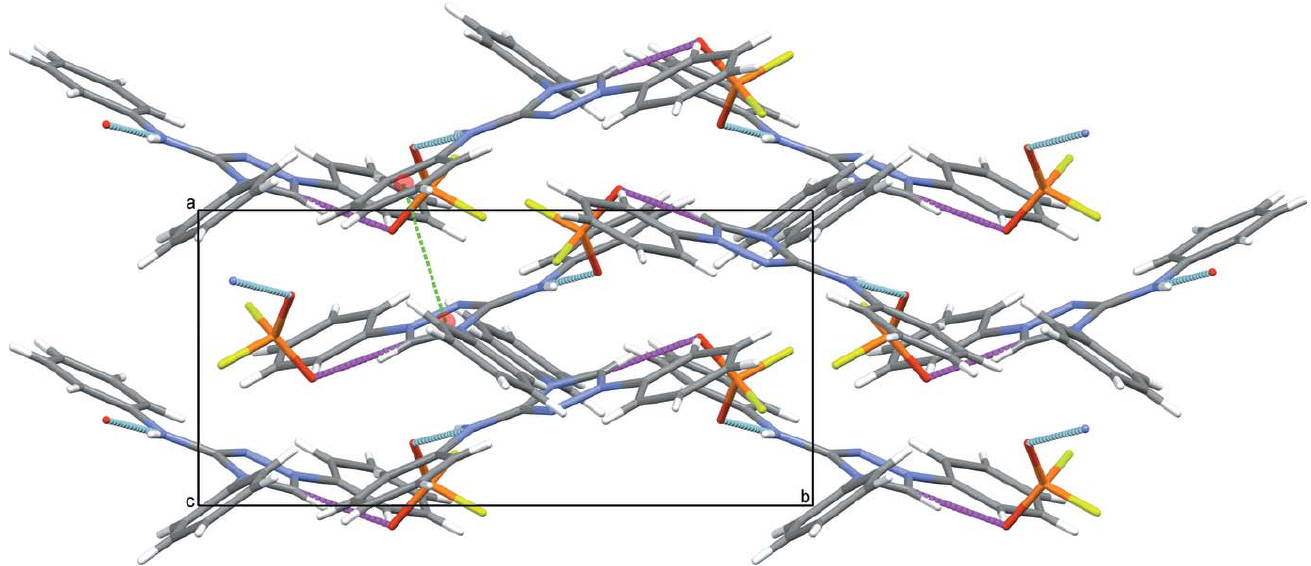
Figure 3 The packing of the organic cations and the inorganic anions in the crystal structure of III in a view along [001]. Intermolecular N—H (cid:3)(cid:3)(cid:3) O and C—H (cid:3)(cid:3)(cid:3) O bonds are shown as light-blue and magenta dashed lines, and (cid:2) – (cid:2) stacking interactions by green dashed